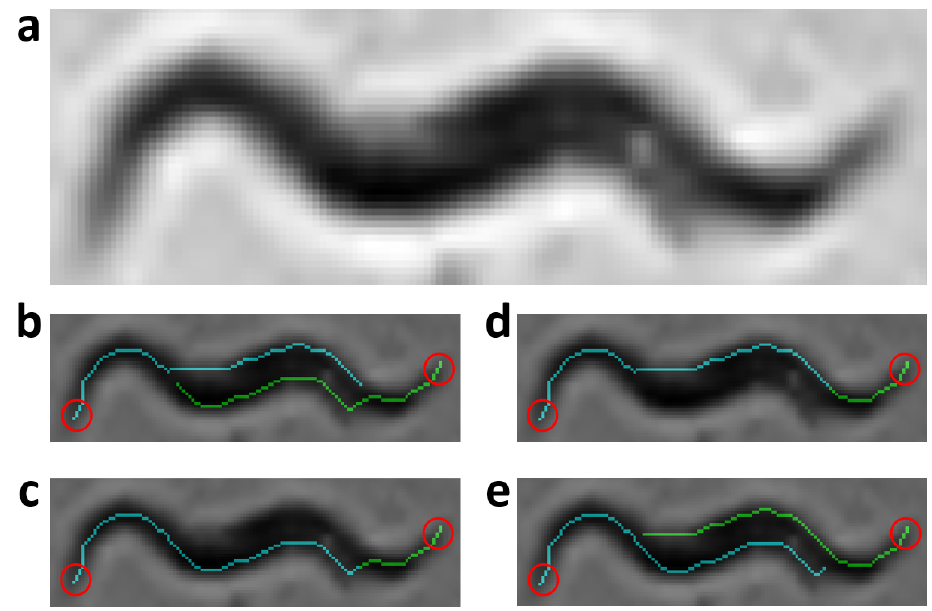
Figure 3. Possible solutions. Circles in red mark the starting point to find the possible skeleton. Cyan and green lines are the possible solutions for each worm. ( a ) Grayscale image. ( b – e ) Possible